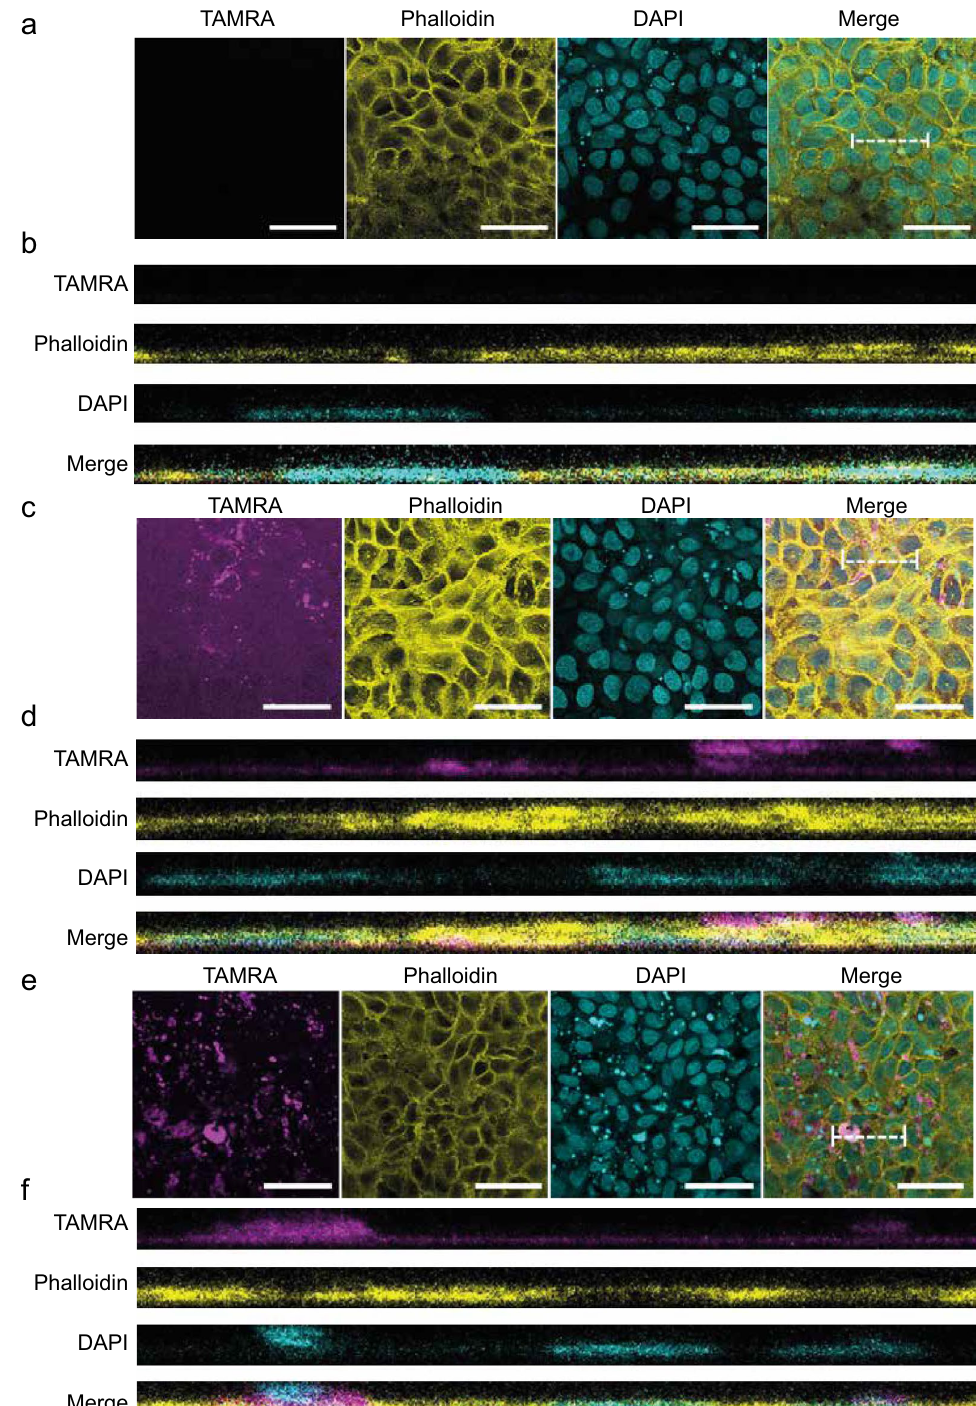
Figure 3. Fluorescent HBD2 localization. HaCaT cells were seeded into ibidi 8-well chamberwell slides. After confluency was reached, cells were treated with vehicle control ( a , b ) or 0.5 μg/ml TAMRA-labelled synthetic HBD2 ( c – f ). Images were collected 48 h after addition of peptide. Cells were fixed in 4% PFA and stained with Alex488 phalloidin (shown as yellow) and Hoechst (shown as cyan) with TAMRA HBD2 (shown as magenta). Images taken with Leica SP8 confocal microscope at 20 × magnification, with z-stacks taken at 0.7 μm intervals. 5 images taken per condition per time point. Representative of n = 2 biological repeats. ( a , c , e ) Representative images of one quarter confocal fields of view. Scale bar represents 50 μm. Dotted white lines indicate areas represented in 3D renderings. ( b , d , f ) Representative images of 3D rendering, generated with LASX